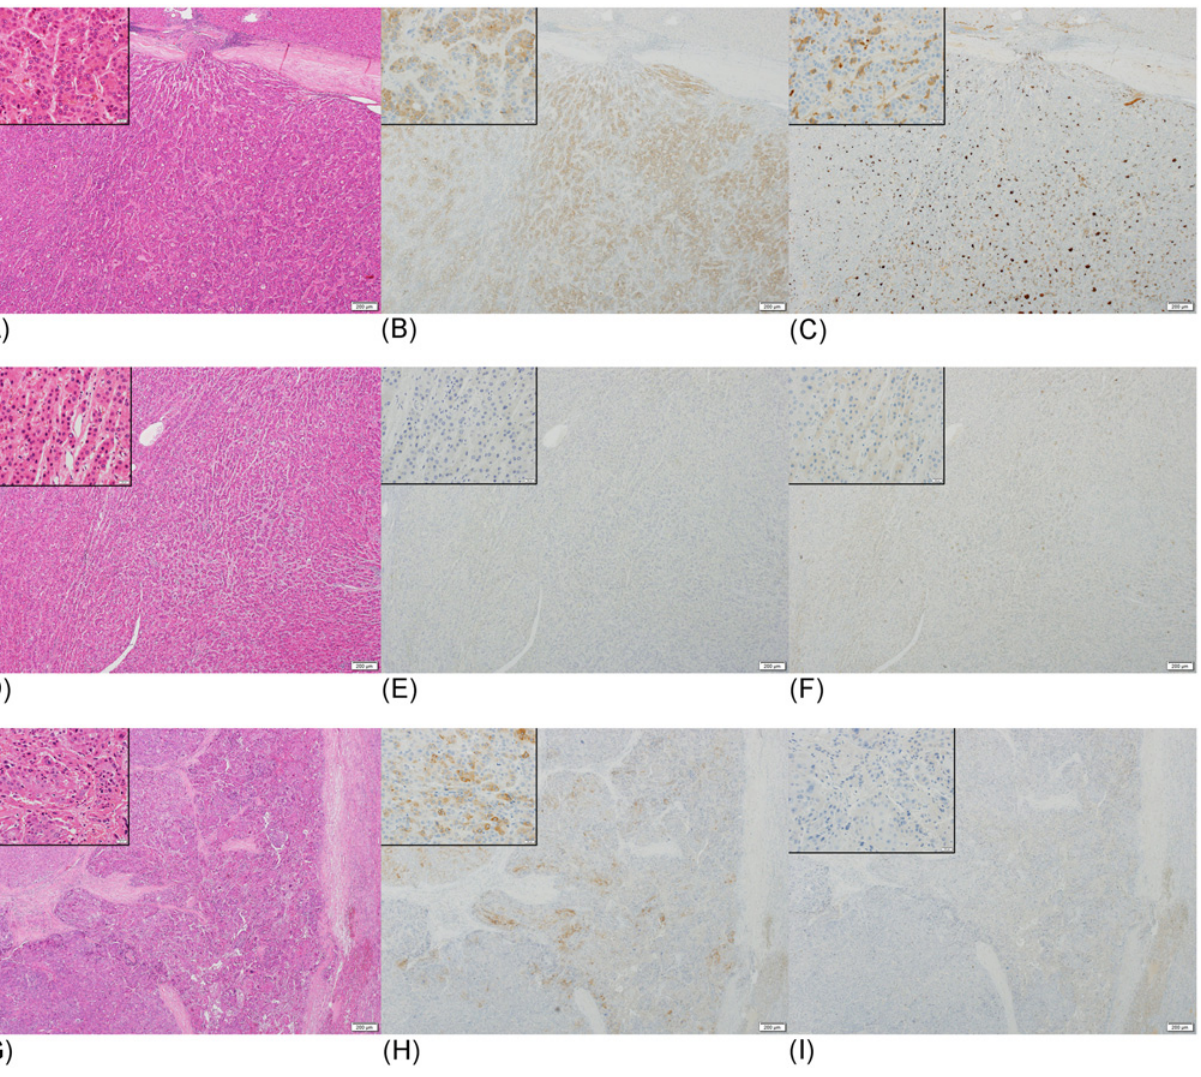
Fig 1. Immunostaining of DCP and NX-DCP in well, moderately, and poor differentiated HCCs. (A-C) A case of moderately differentiated HCC showing both DCP and NX-DCP expression. HE stain (A), and immunostain for DCP (B) and NX-DCP (C). DCP-positive area overlaps with NX-DCP-positive area. (D-F) A case of well-differentiated HCC showing NX-DCP expression, but no DCP expression. HE stain (D), and immunostain for DCP (E) and NX-DCP (F). (G-I) A case of poorly differentiated HCC showing DCP expression, but no NX-DCP expression. HE stain (G), and immunostain for DCP (H) and NX-DCP (I).